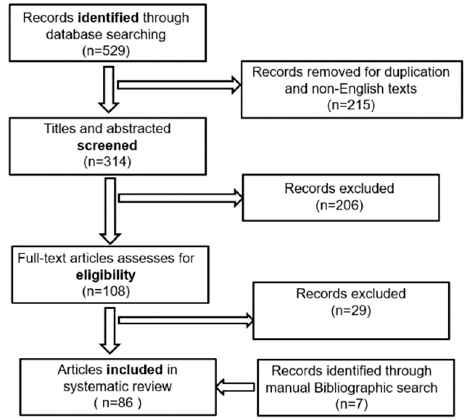
Figure 1. Flow diagram depicting the systematic review strategy.